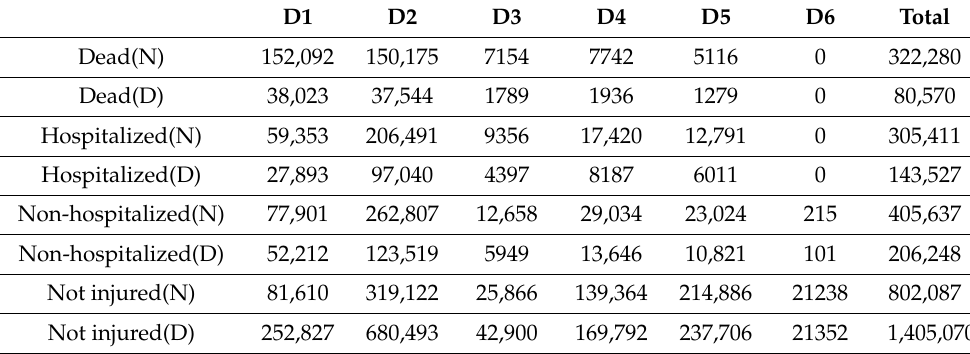
Table 9. Mortality rate in Tabriz city for the 1721 earthquake.